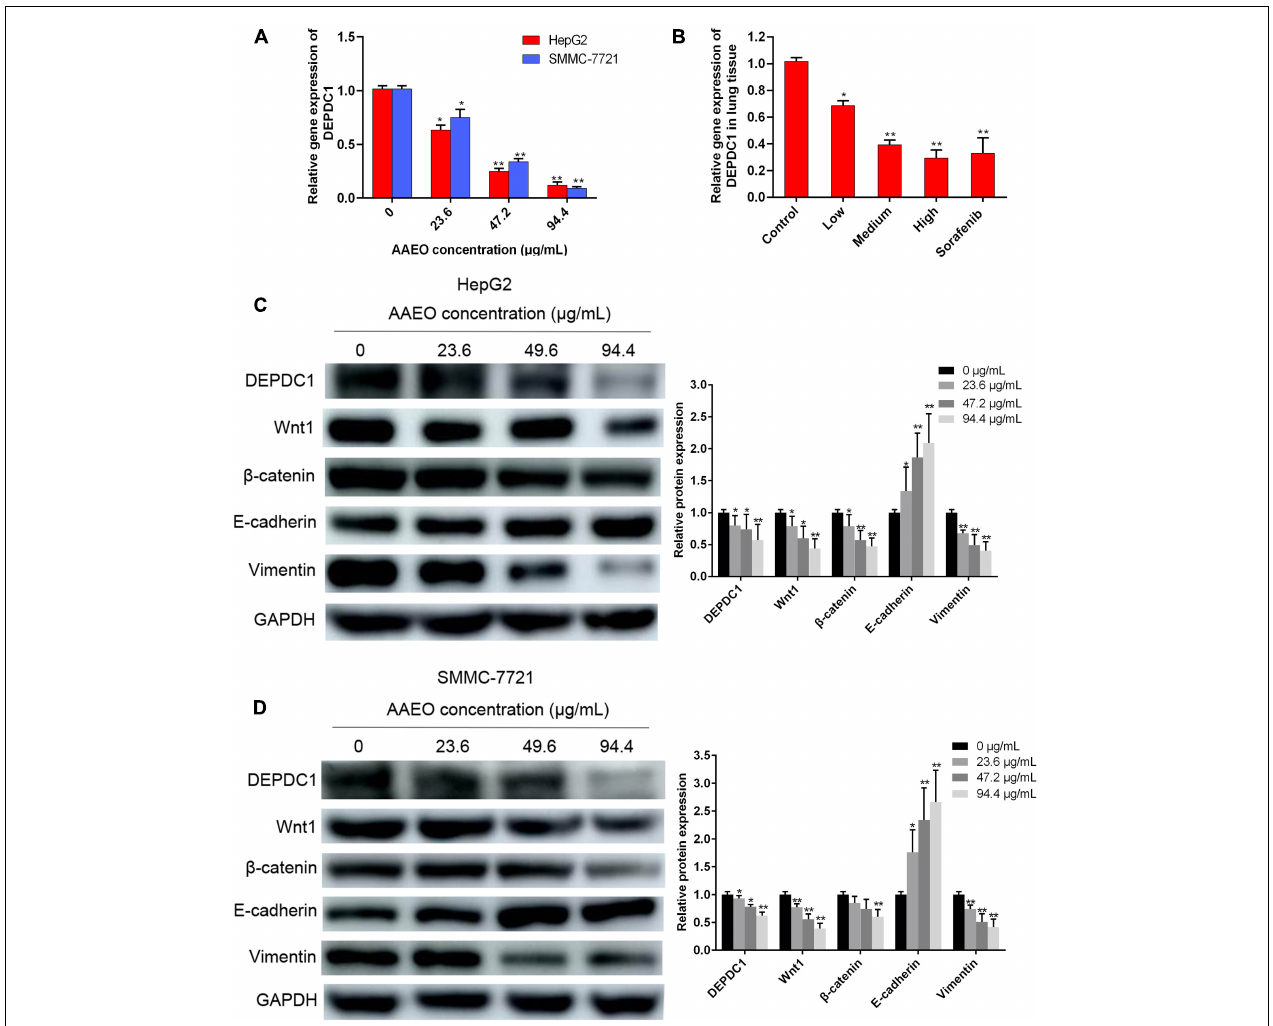
FIGURE 5 | AAEO treatment suppresses DEPDC1 expression, attenuates Wnt/ β -catenin signaling, and prevents EMT. (A) Fold changes in DEPDC1 expression in HepG2 and SMCC-7721 cells after AAEO treatment for 72 h. (B) Fold changes in DEPDC1 expression in lung metastasis tissue from nude mice after AAEO treatment for 21 days. (C,D) DEPDC1, Wnt1, β -catenin, and EMT related protein expression in HepG2 cells (C) and SMMC-7721 cells (D) assessed by western blotting after AAEO treatment for 72 h. Data are expressed as the mean ± SD of three independent experiments. *p < 0.05 and **p < 0.01 vs. the control